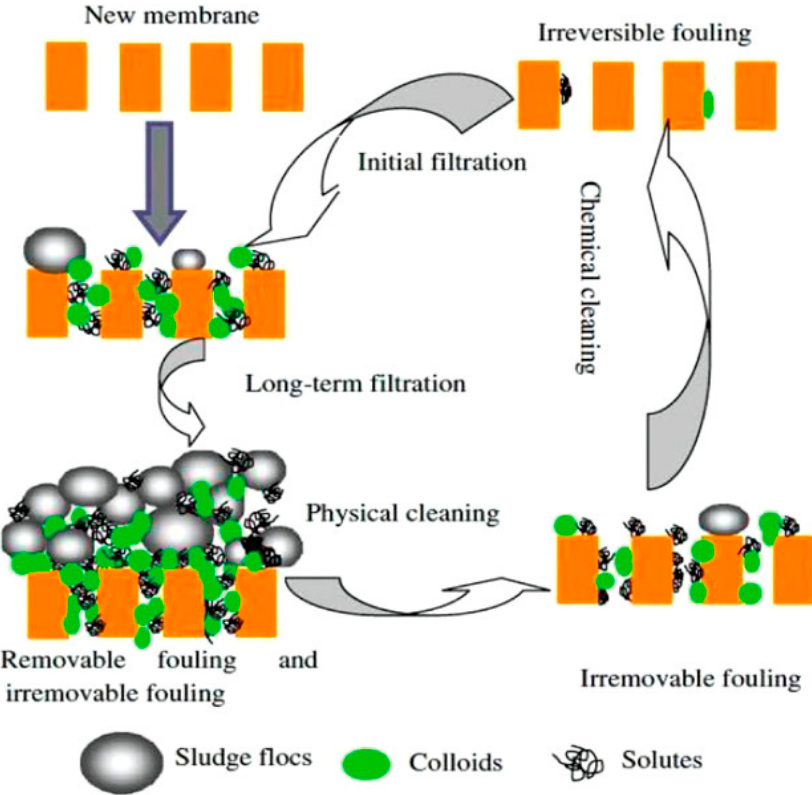
Figure 5. Basic diagram outlining the process of fouling in MBRs, as well as the methods used for its removal. (Source: [163] copyright permission received on 15 February 2023, from